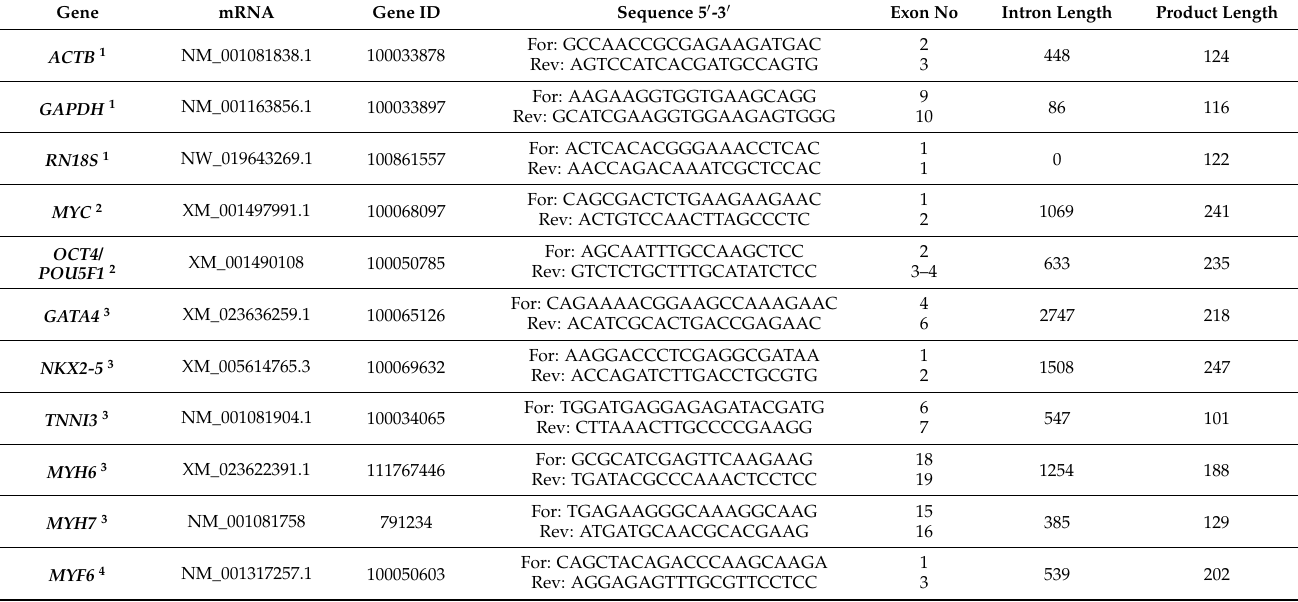
Table 1. List of primers used for SYBR Green quantitative reverse-transcription real-time